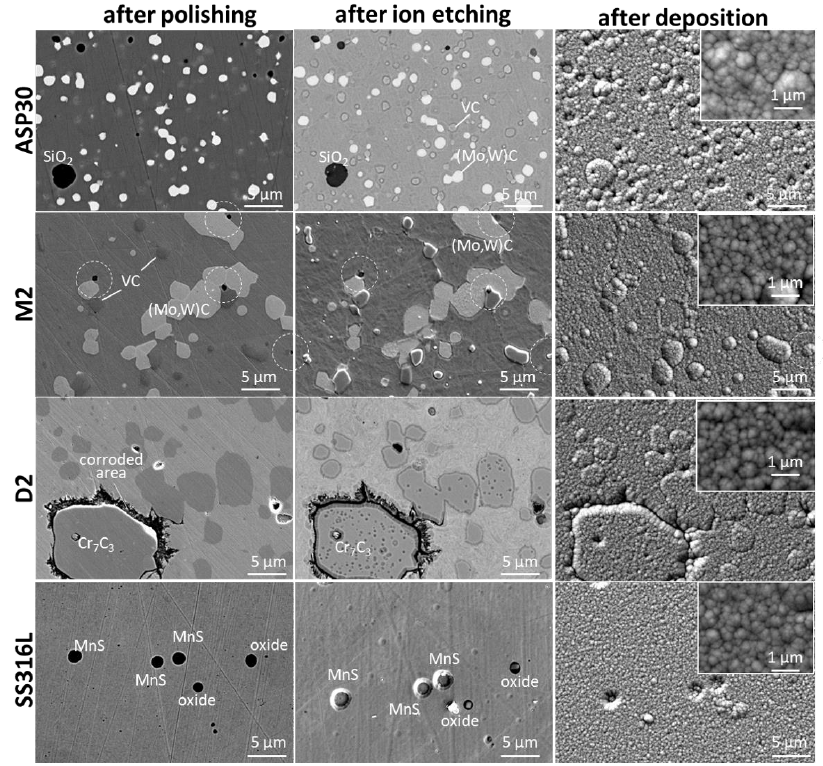
Figure 7. Top-view SEM images of the same surface area of ASP30, M2, D2 and SS316L steel substrates after polishing, ion etching (MF and booster) and deposition of the NL-TiAlN/CrN hard coatings. SEM images of the coating morphology at high magnification are shown in the insets. During polishing, the removal rate of harder inclusions (e.g., carbides or oxides) is lower than the matrix; however, it is higher if inclusions are softer than the matrix (e.g.,